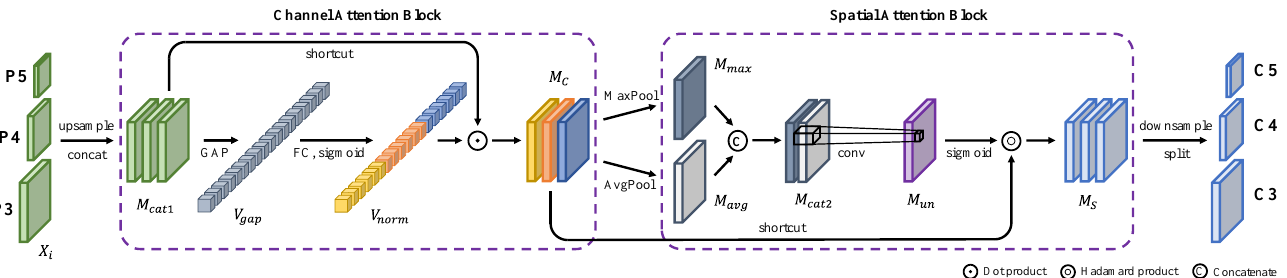
Figure 6. JFW structure. The channel attention and spatial attention blocks are two main components of JFW, in which the channel attention block is cascaded, followed by the spatial attention block. In the channel attention block, the feature map is weighted by a channel descriptor that is squeezed by global spatial information. In the spatial attention block, the feature map is further weighted by a spatial descriptor that focuses on the informative part of the feature